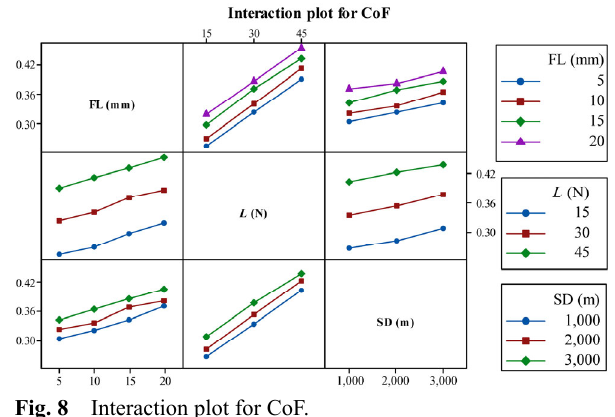
Fig. 8 Interaction plot for CoF.